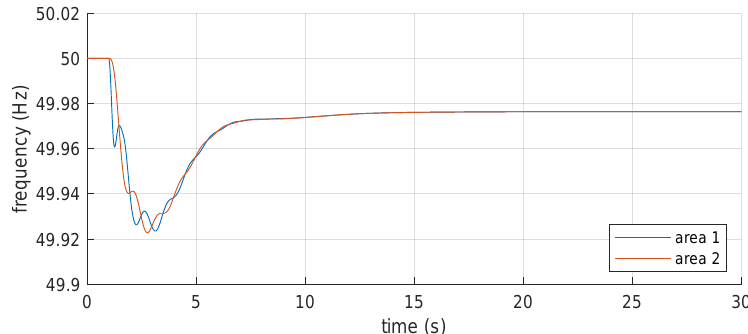
Figure 12. Grid-following (in Area 1) and grid-forming (in Area 2).